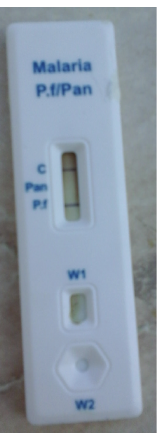
Figure 1: Positive RDT for Plasmodium falciparum